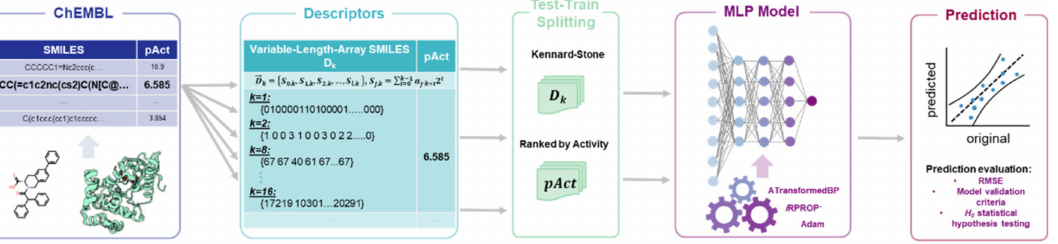
Figure 1. Flowchart of our MLP-based QSAR modeling using variable-length-array numerical SMILES-based descriptors. Batch-trained affine transformed BP (ATransformedBP), epoch trained resilient propagation (iRPROP − ), and Adam optimizer learning algorithms form the foundation of the developed MLP